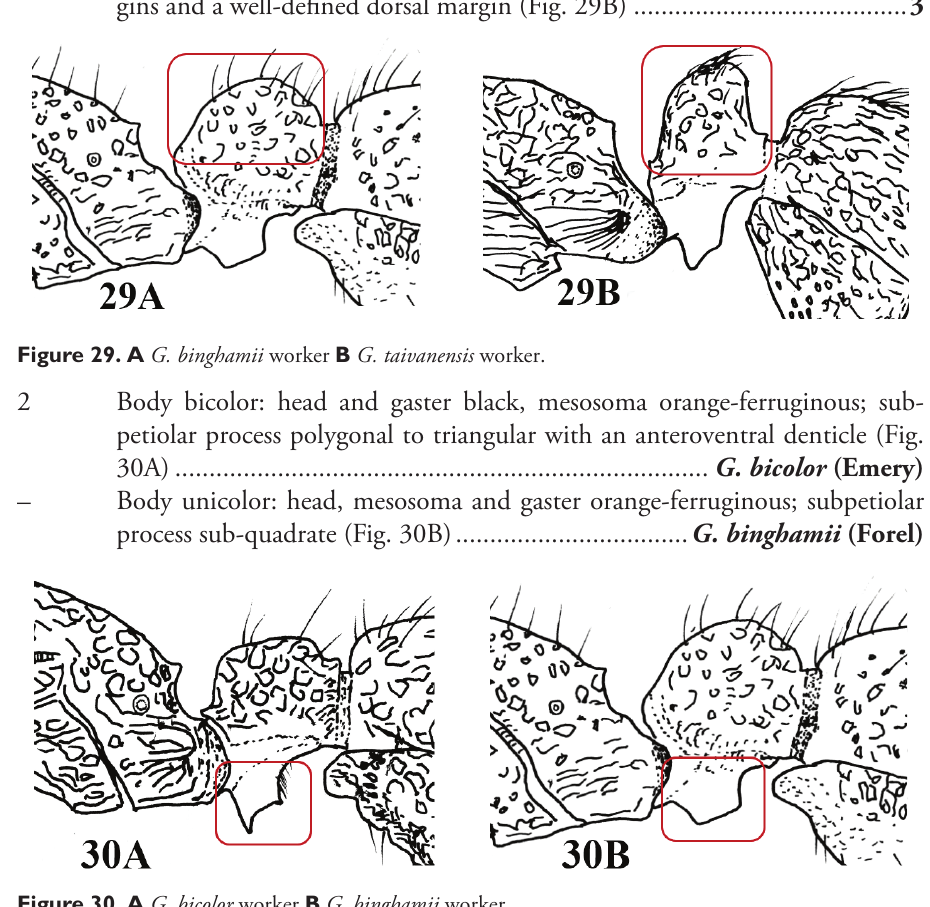
Figure 30. A G. bicolor worker B G. binghamii